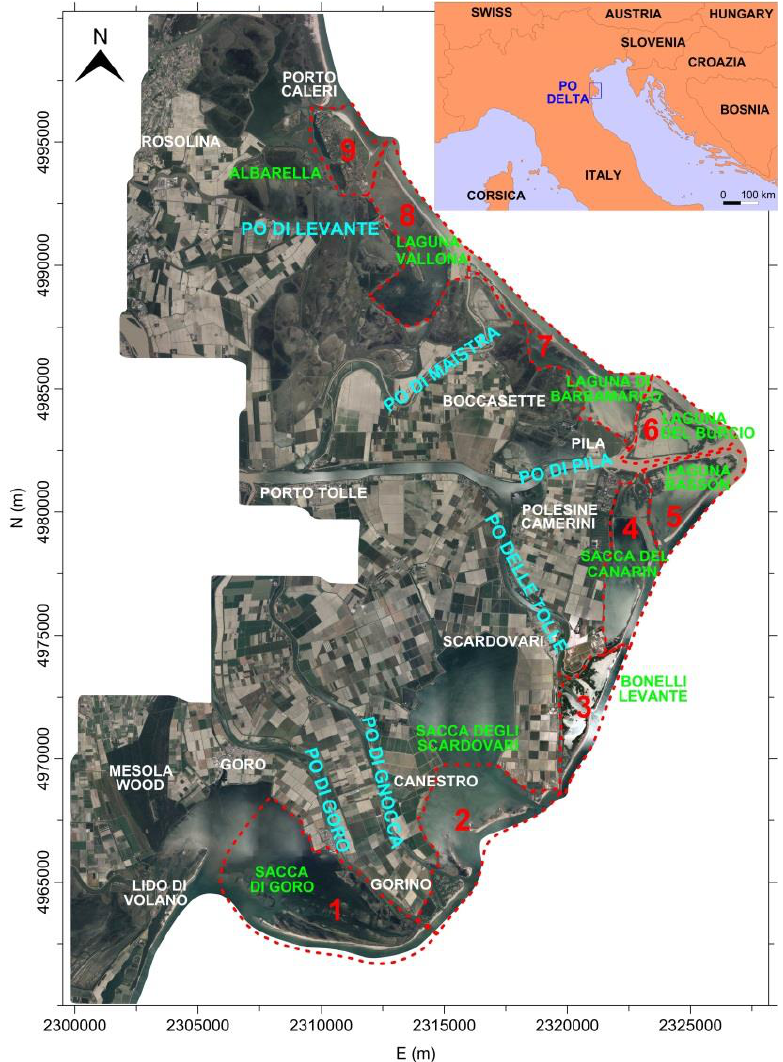
Figure 1. Location of PRD area in northern Italy, the river branches, the main villages, and subdivision of emerged surfaces outside the levees in nine sub-areas (red dashed lines): ( 1 ) Sacca di Goro; ( 2 ) Sacca degli Scardovari; ( 3 ) Bacino Bonelli Levante; ( 4 ) Sacca del Canarin; ( 5 ) Laguna Basson; ( 6 ) Laguna del Burcio; ( 7 ) Laguna di Barbamarco; ( 8 ) Laguna Vallona; ( 9 ) Isola di Albarella. Coordinates are in the Gauss–Boaga Italian reference system.